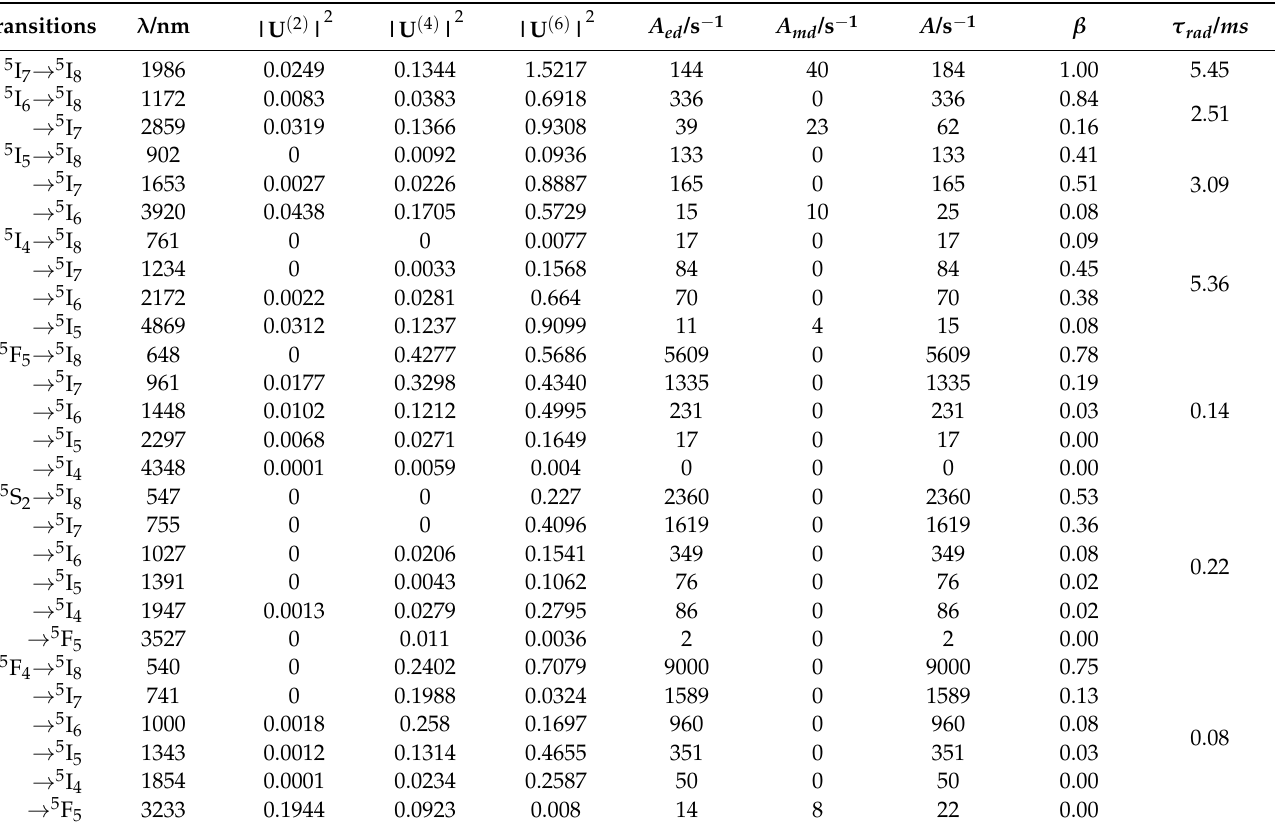
Table 4. The calculated results of the spectroscopic parameters of PMN-32PT:Ho 3+ /Yb 3+ crystal.